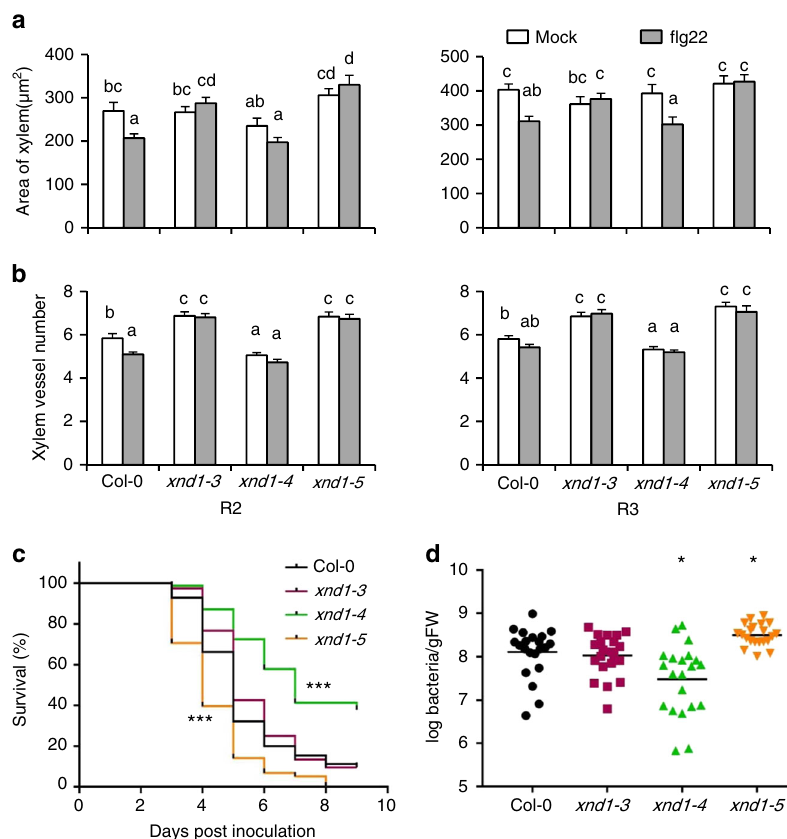
Fig. 7 XND1 mediates the inhibition of xylem formation by fl g22 and resistance to R. solanacearum . a , b Plants of the indicated genotype were grown for 4 days in the absence (mock) or in the presence of 0.25 µ M fl g22 ( fl g22). R2 and R3 root segments (see Fig. 5a) were cross-sectioned and xylem area ( a ) and xylem vessel number ( b ) were measured. Data are means ± SE from 18 – 50 sections in 6 – 10 plants and two independent experiments. One-way ANOVA (Fisher ’ s LSD, P < 0.05) was used to test the signi fi cance of the data. c The indicated genotypes were inoculated with R. solanacearum through root dipping and plant survival (in %) was scored at the indicated days postinoculation. Cumulated data from three independent biological experiments, each with three technical repeats comprising at least 24 – 32 plants. Stars indicate signi fi cant differences from Col-0 based on a Gehan – Breslow – Wilcoxon test ( P < 0.0001). The Col-0 and xnd1 – 3 curves were not signi fi cantly different ( P = 0.1304). d in planta growth measurement of R. solanacearum at 3 days after inoculation of the indicated genotypes. Each dot represents a replicate of two plants and the black line indicates the mean of all the replicates. Cumulated data from four independent biological repeats. Asterisks indicate a signi fi cant difference with Col-0 (Mann – Whitney test ; P <